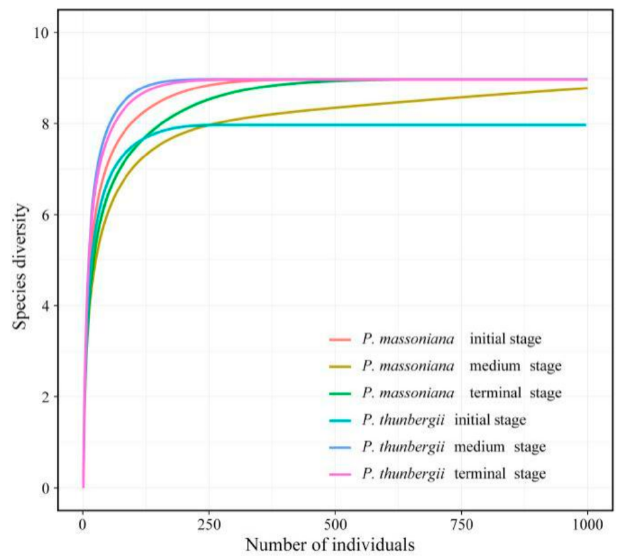
Figure 2. Rarefaction curves of the species richness level of P. massoniana and P. thunbergii at different affected stages. The red, yellow, and green curves represent the P. massoniana samples in three stages; the cyan, blue, and purple curves represent the P. thunbergii samples in three stages. Broken lines represent the 95% confidence interval for each curve.